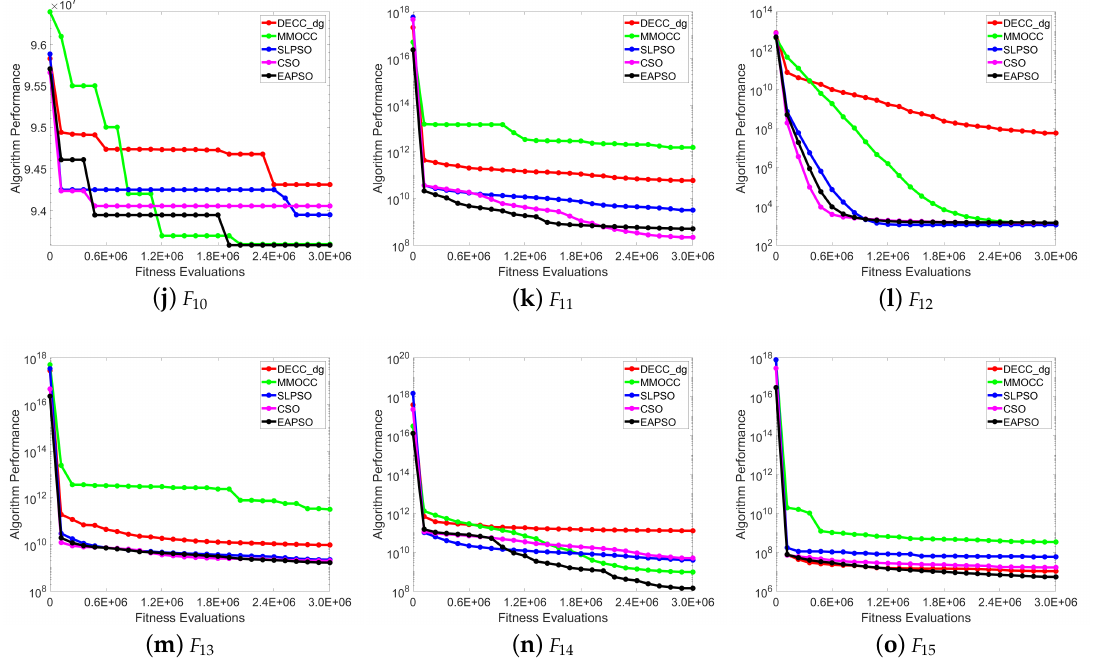
Figure 2. Convergence profiles of different algorithms obtained on the CEC’2013 test suite with 1000 dimensions.